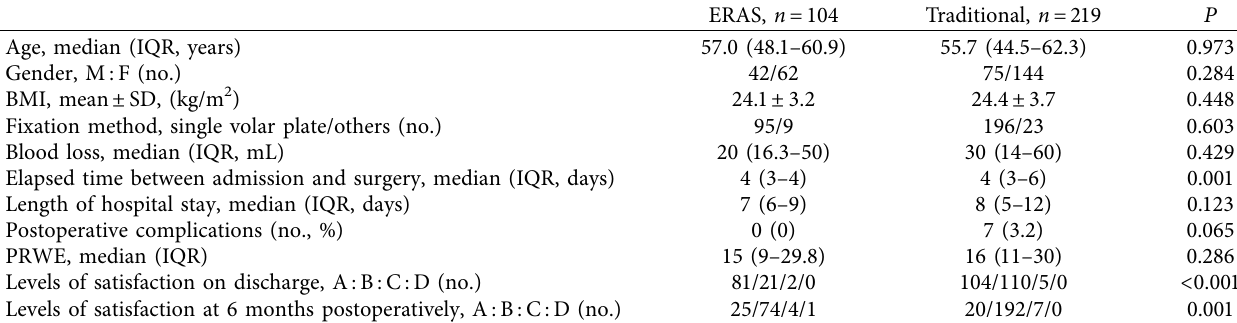
Table 6: Subgroup analysis among patients with distal radial fracture.